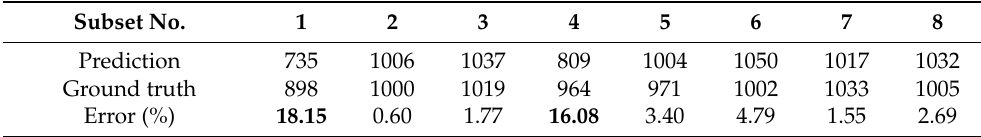
Figure 11. Comparison of the prediction images and ground truth images of Subset 1 in the detection demonstration. Table 8. Comparison of the hill number of rice seedlings from patch-based detection and the ground truth.